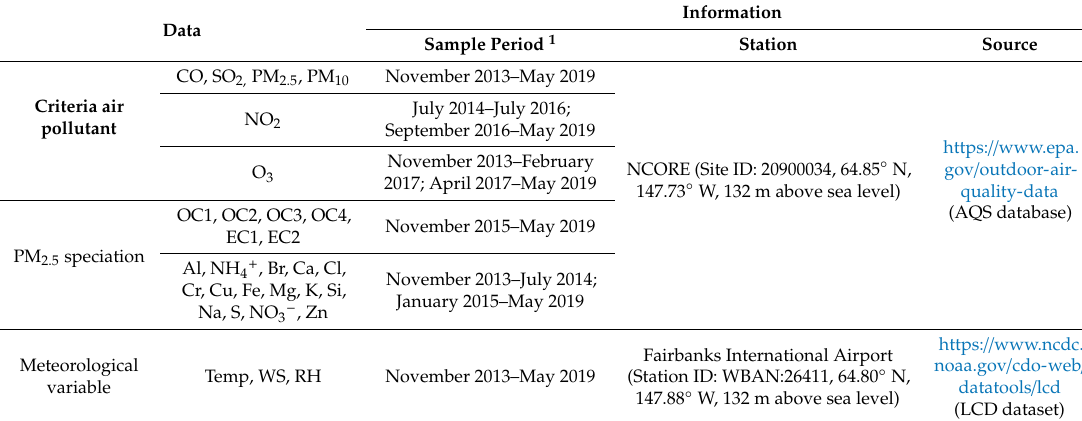
Table A1. Sample sites, sample periods, and sources of data used in the